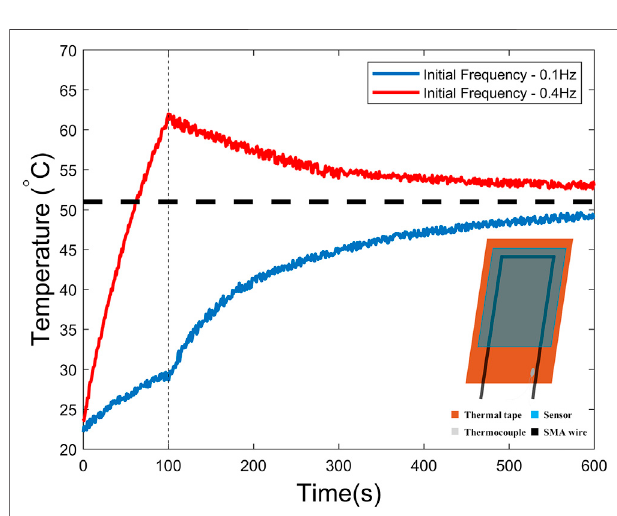
FIGURE 9 | Temperature measurements with different initial open-loop frequency. The closed-loop control strategy is implemented after 100 s. The stable temperature is around 52 °